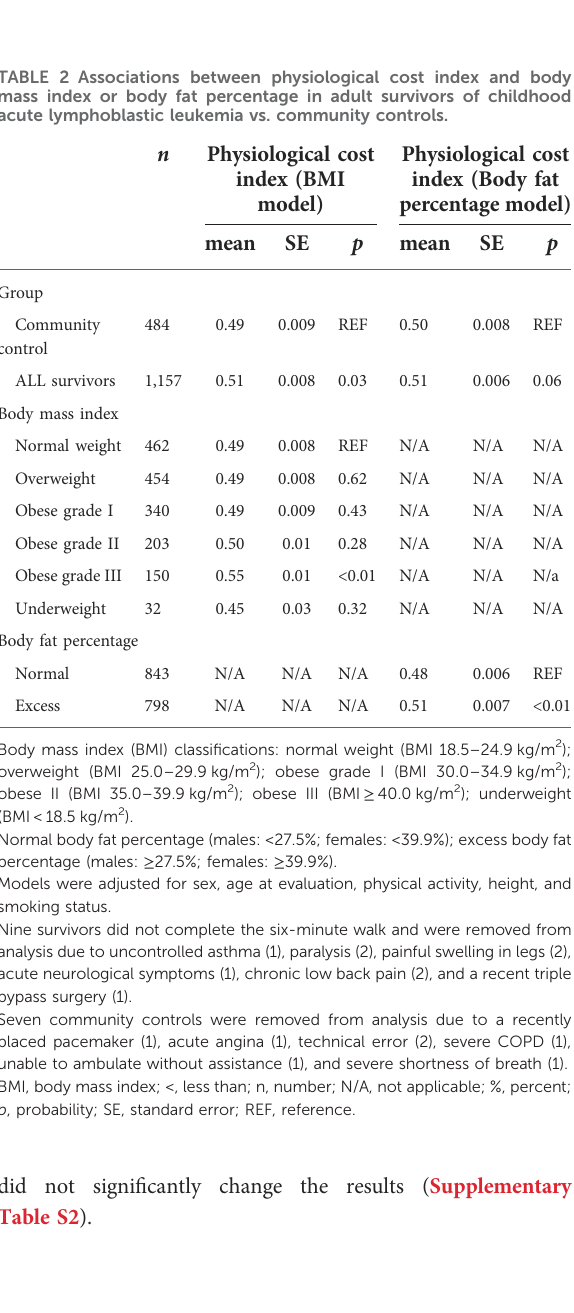
neuropathy, and PCI in three sequential multivariable models (A, B, and C) in survivors. After adjustment for treatment